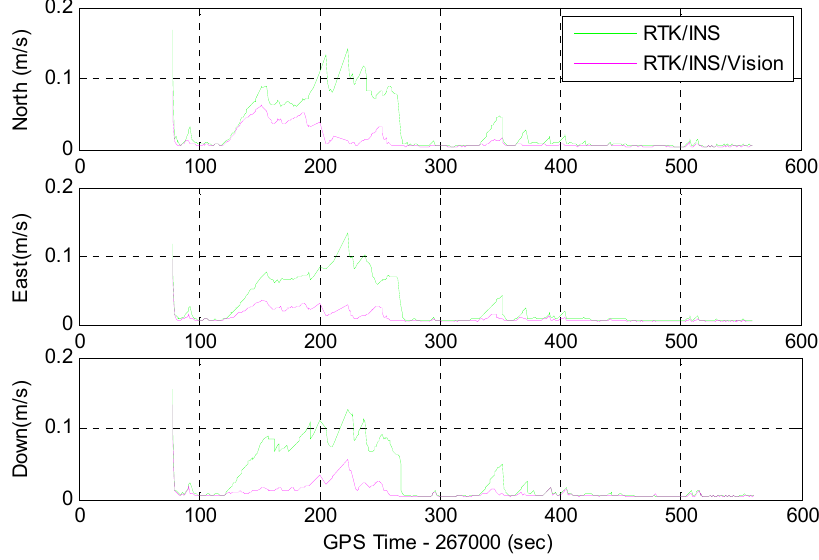
Figure 17. The velocity STD series of the GPS + BDS + GLONASS RTK/INS integration and the corresponding RTK/INS/Vision integration in the north, east, and down directions. The STDs are the square roots of the corresponding diagonal elements of the state covariance matrix and the values have been transformed from the e -frame to the north–east–down frame.